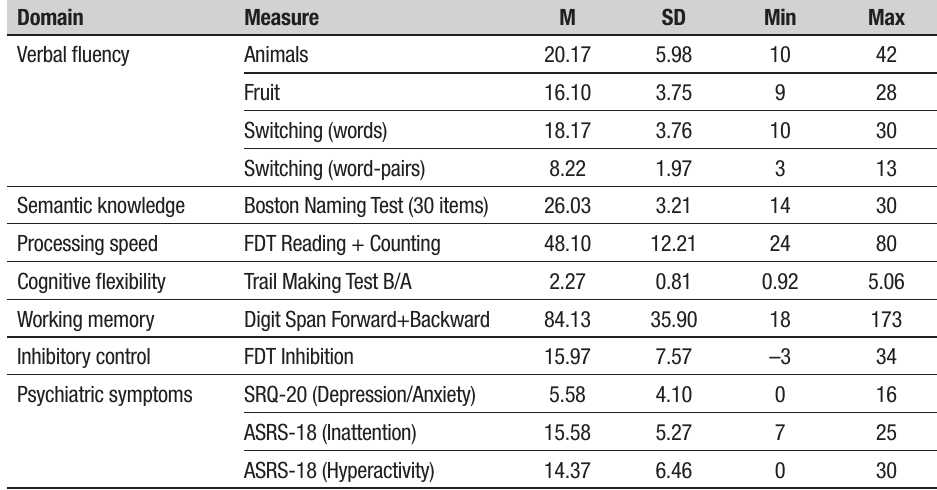
Table 2. Participant performance on neuropsychological tests and self-reported psychiatric symptoms.